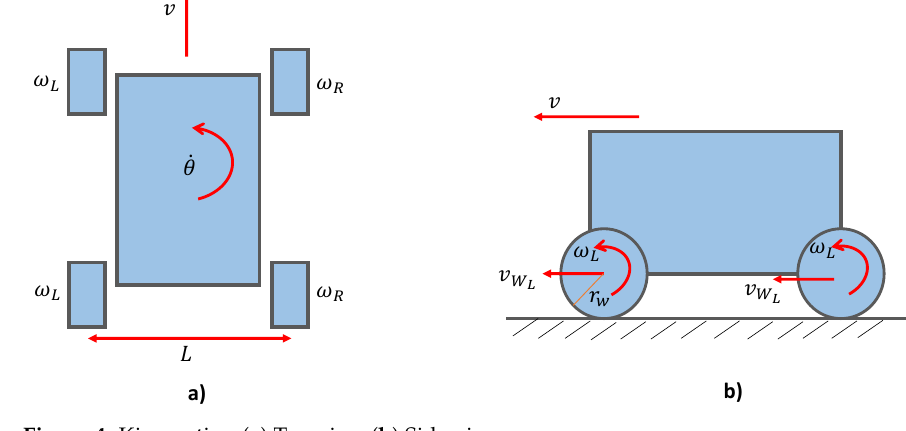
Figure 4. Kinematics. ( a ) Top view ( b ) Side